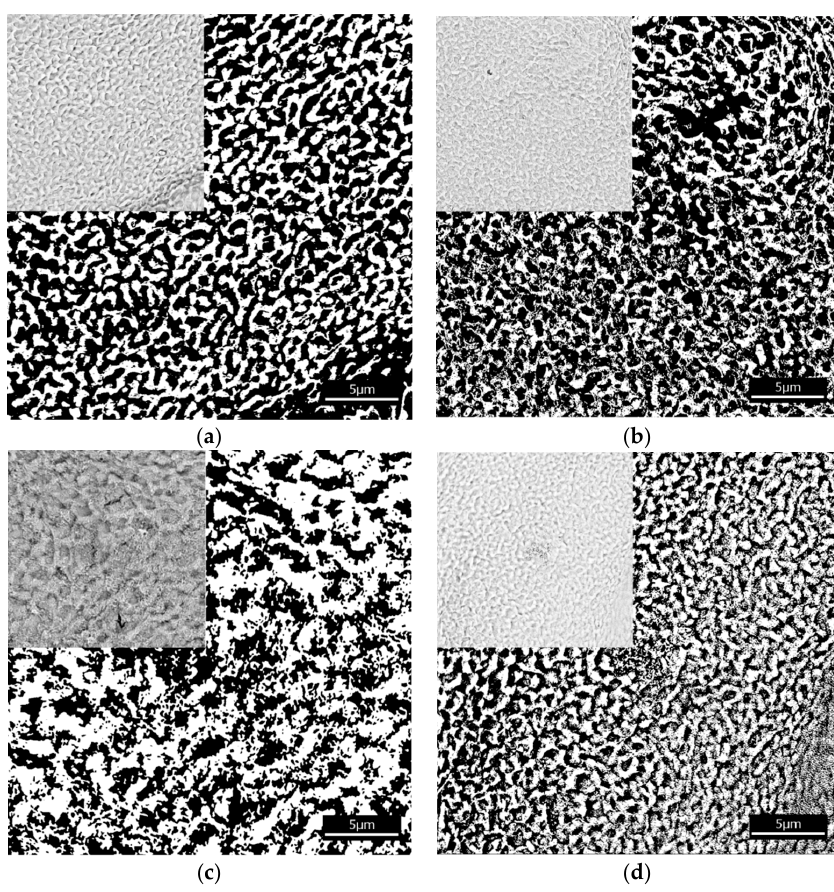
Figure 2. Images of the alginate membranes filled with various chitosan particles ( a ) neat (CS), ( b ) phosphorylated (CS-P), ( c ) glutaraldehyde crosslinked (CS-GA), and ( d ) glycidol-modified (CS-G) both before (upper left side corner) and after binarization. Black regions correspond to the void spaces and white regions to the polymer matrix.